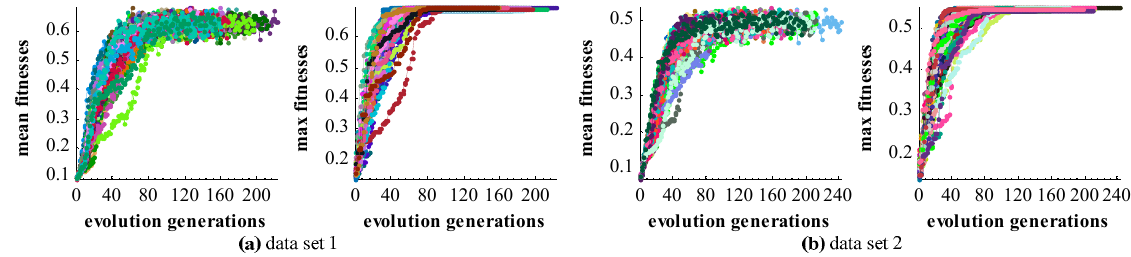
Figure 10. The mean and maximum fitness values of GA. A polyline with random color represents the change of the fitness value of one experiment. ( a ) The change of the fitness values of data set 1; ( b ) the change of the fitness values of data set 2.